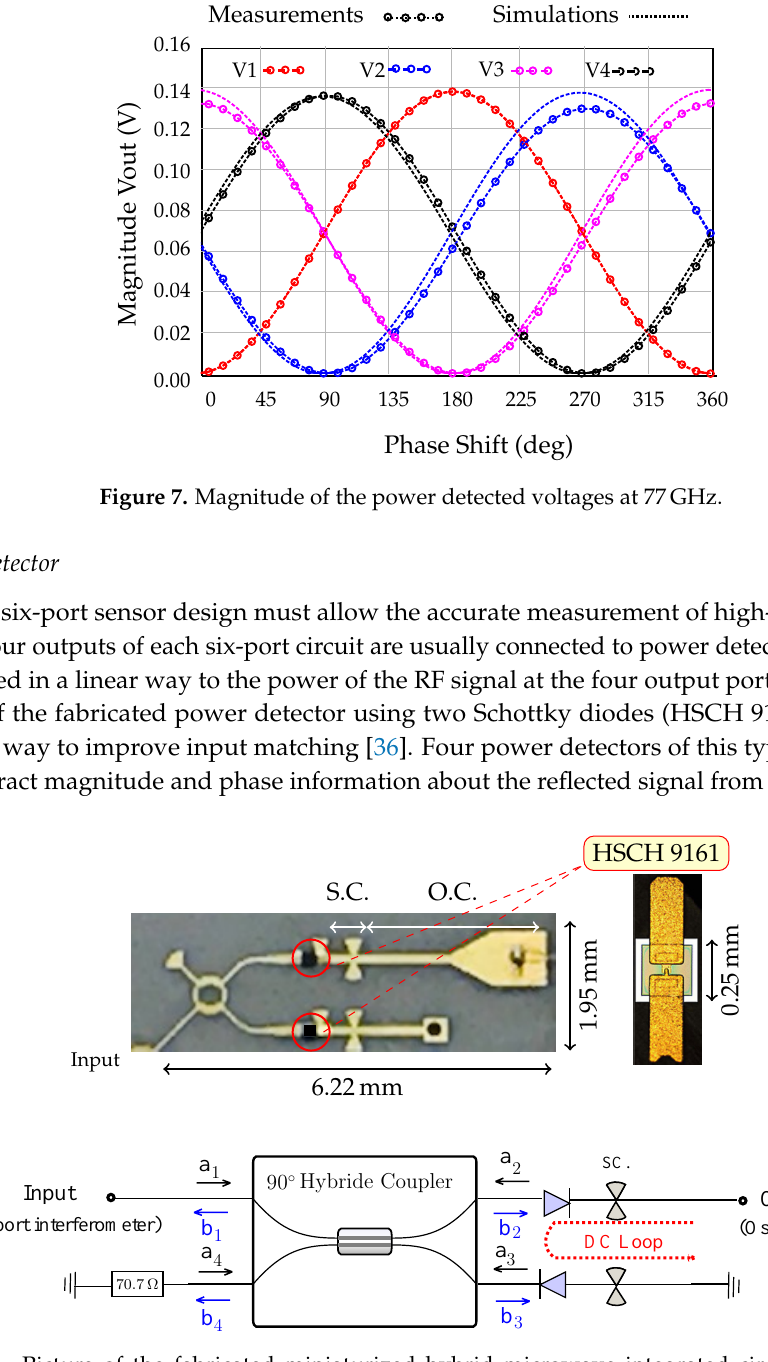
Figure 8. Picture of the fabricated miniaturized hybrid microwave integrated circuit (MHMIC) diode-based power detector and a schematic diagram of the power detector.